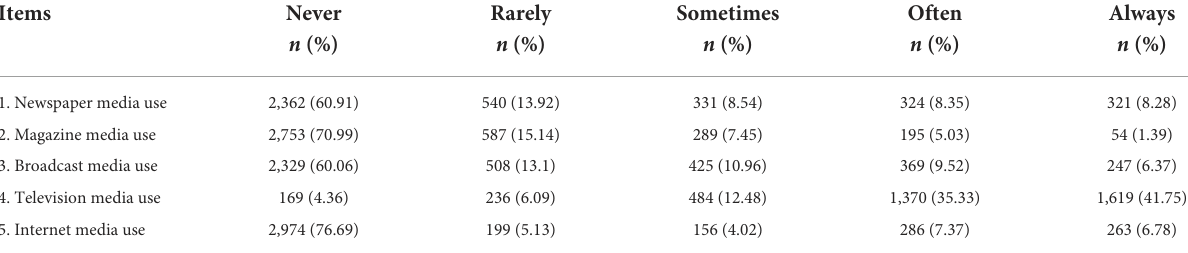
TABLE 3 Results of variance